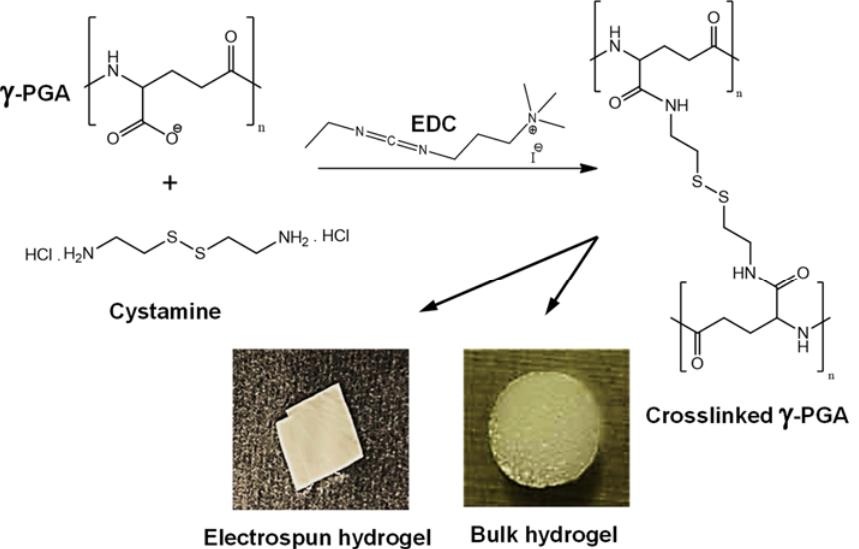
Figure 3. Scheme showing hydrogel preparation from γ -PGA and representative images of the two types of prepared hydrogels.